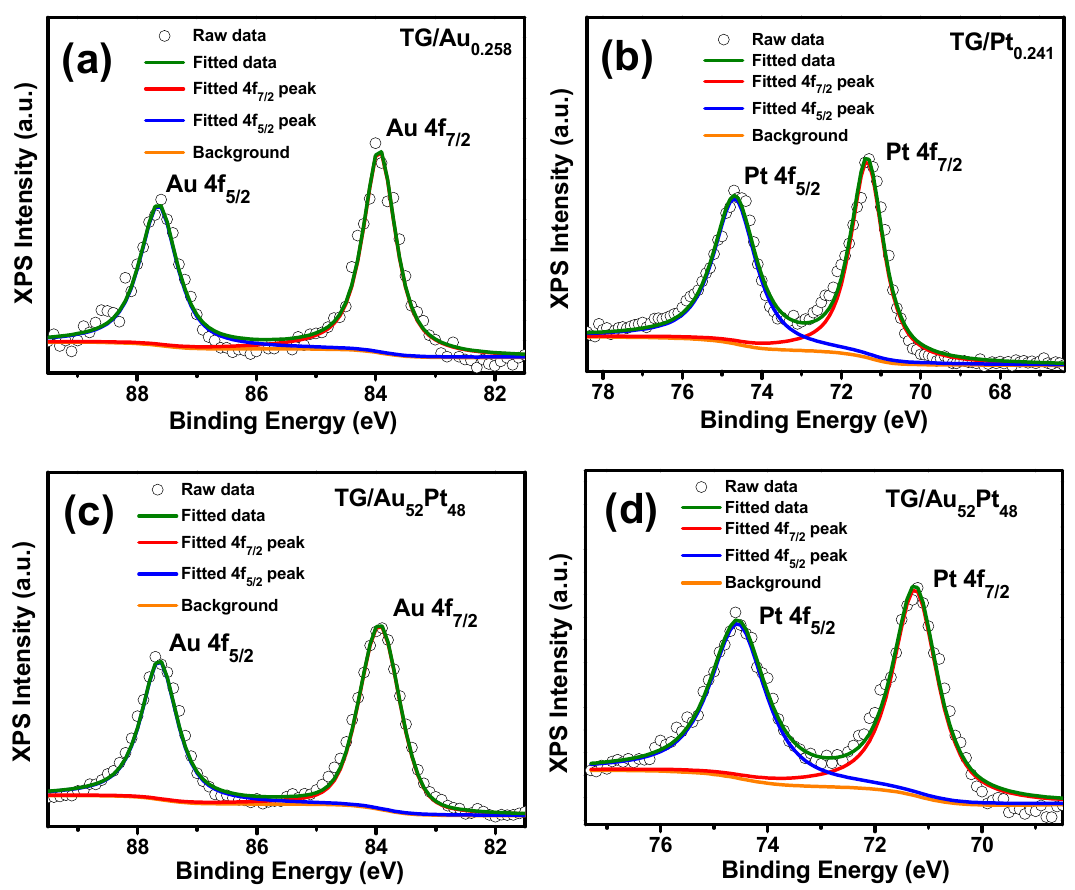
Figure 6. Au 4f ( a , c ) and Pt 4f ( b , d ) narrow scans of the TG decorated with noble metal NPs and their corresponding fitting components.